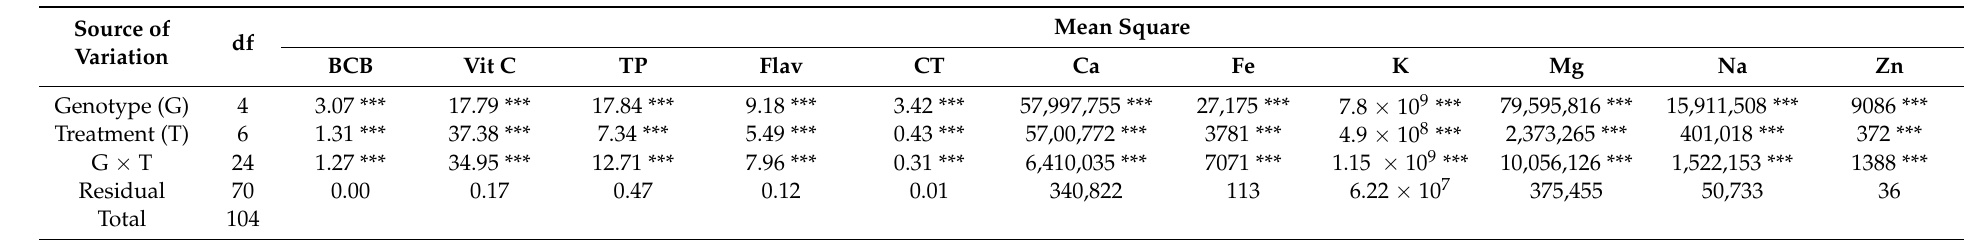
Table 4. Analysis of variance for the effect of biostimulant and genotype on Abelmoschus esculentus nutritional and phytochemical contents. df = Degree of freedom,